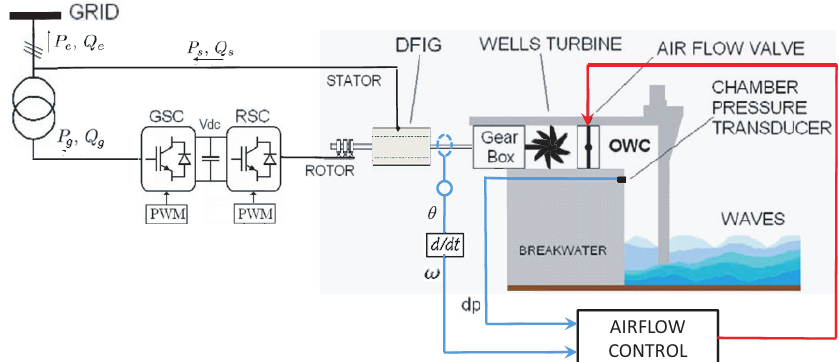
Figure 10. Airflow control scheme for a Wells turbine-based OWC wave power plant. GSC, Grid-Side Converter; RSC, Rotor-Side